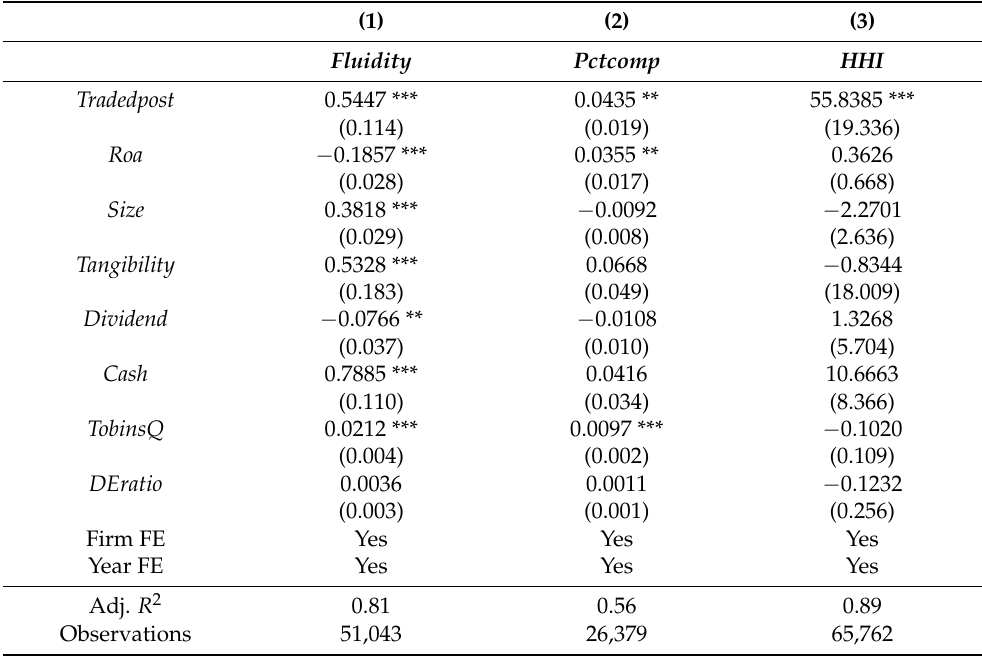
Table 3. CDS initiations and product market competition. This table reports the results of our baseline regression model (1) for different competition measures. Standard errors were clustered by firms and reported in parentheses. Lagged firm-specific controls and the firm and year fixed effects are included in all specifications. Coefficients with ** or *** indicating a significance level of 0.05 or 0.01, respectively. For detailed definitions of variables, please refer to Appendix A Table